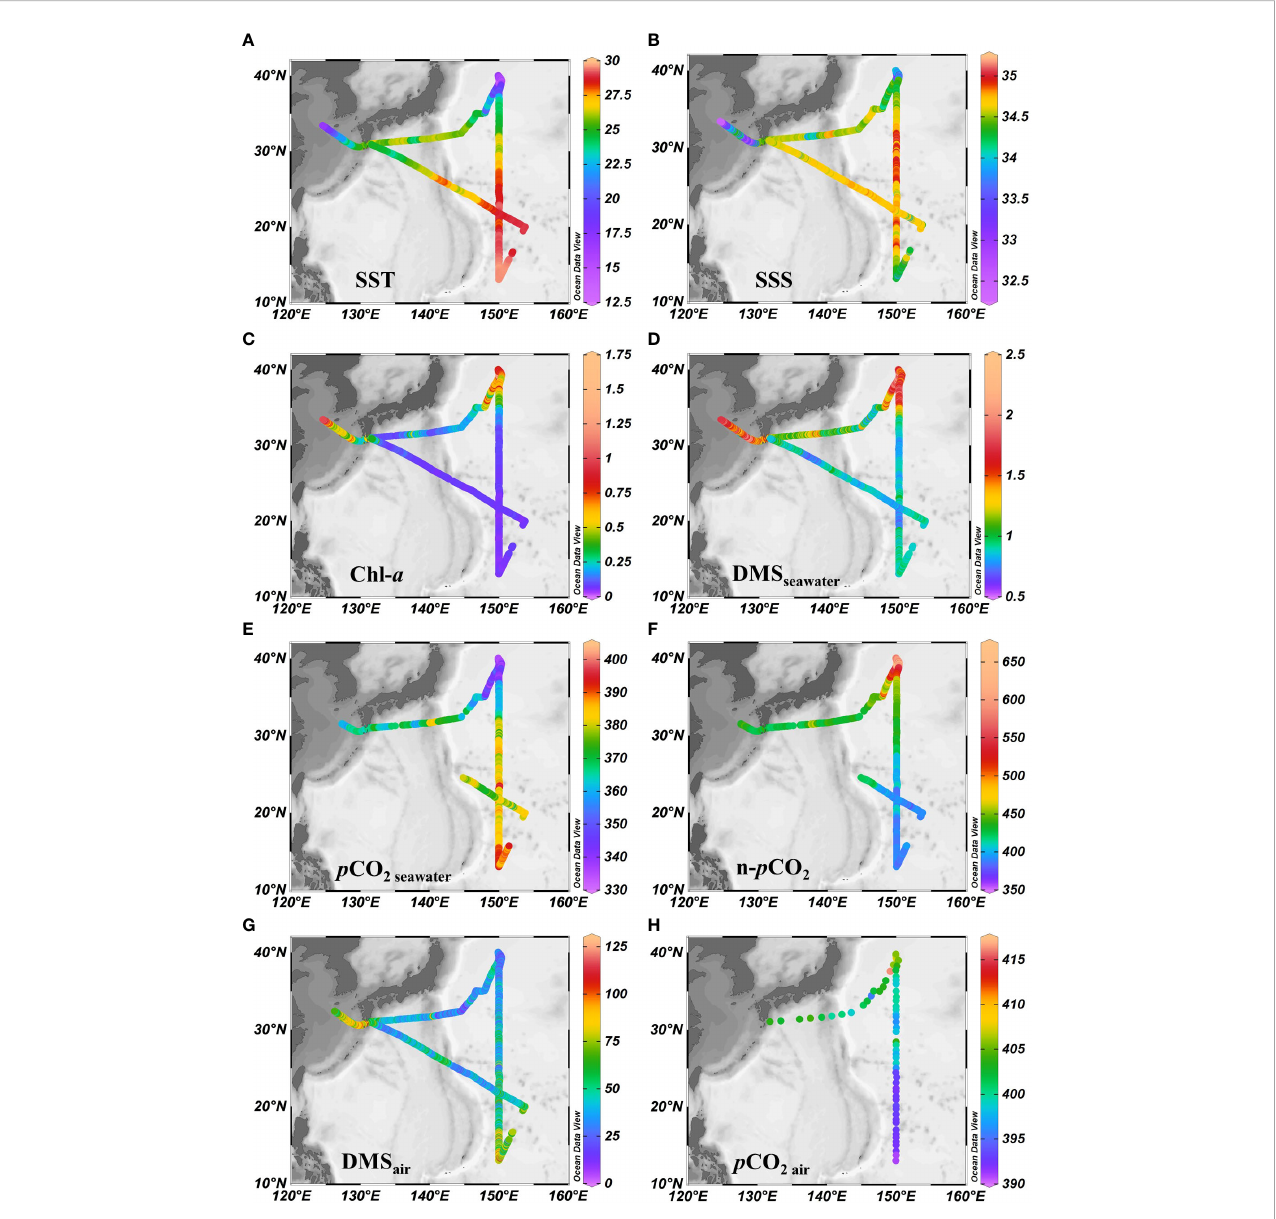
FIGURE 2 Horizontal distributions of underway (A) SST (°C), (B) SSS, (C) Chl- a ( m g L -1 ), (D) DMS seawater (nmol L -1 ), (E) p CO seawater 2 ( m atm), (F) n- p CO 2 ( m atm), (G) DMS air (pptv), and (H) p CO air 2 ( m atm). Note that n- p CO 2 was calculated using the formula n- p CO 2 = p CO 2 × exp [0.0423 × (29.5 - SST)]) following Takahashi et al. (2002), where n- p CO 2 is the sea surface p CO 2 when the temperature is normalized to the mean temperature of NECR